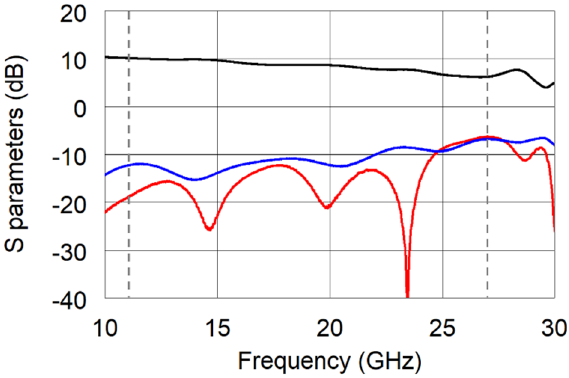
Figure 3. Measured S 21 (black solid line), S 11 (blue solid line), and S 22 (red solid line) of the APM-6849 amplifier.